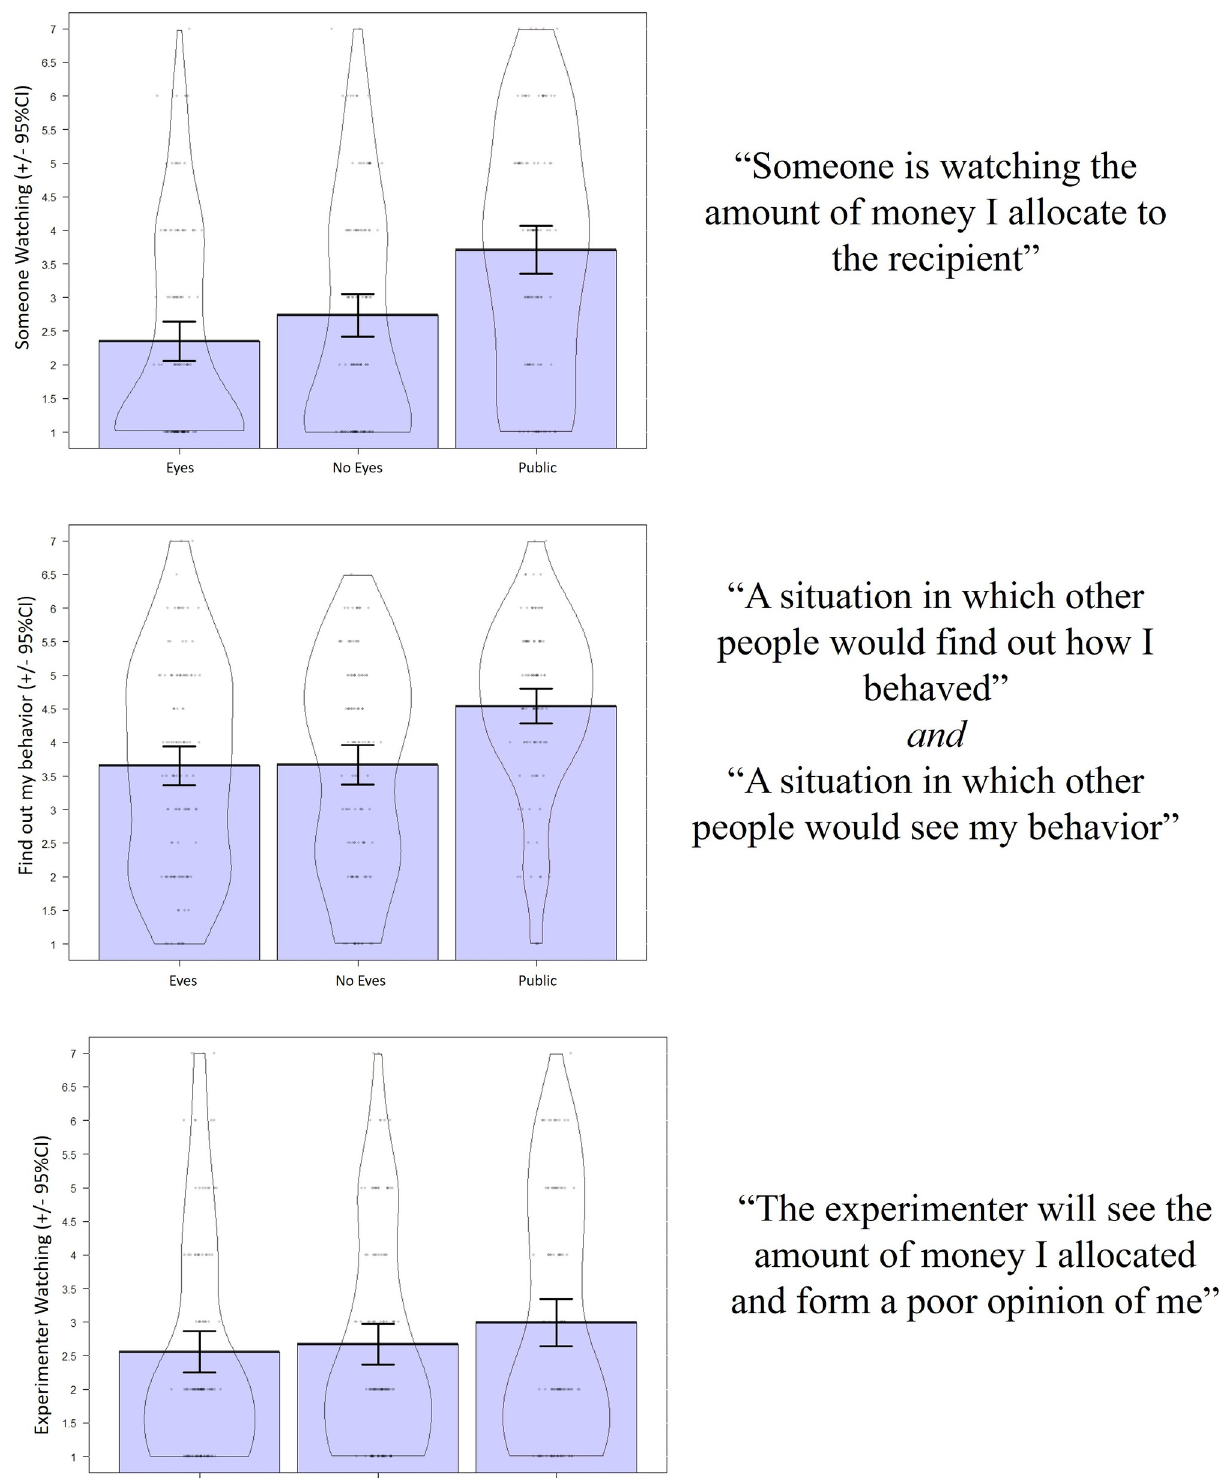
Fig 2. Participant agreement with post-experimental questions by condition (+/- 95% CIs), and the associated question(s) to the right. Colored areas represent traditional bar graphs. Contours are violin plots which demonstrate the distribution of responses for that condition. Dots are individual responses, with